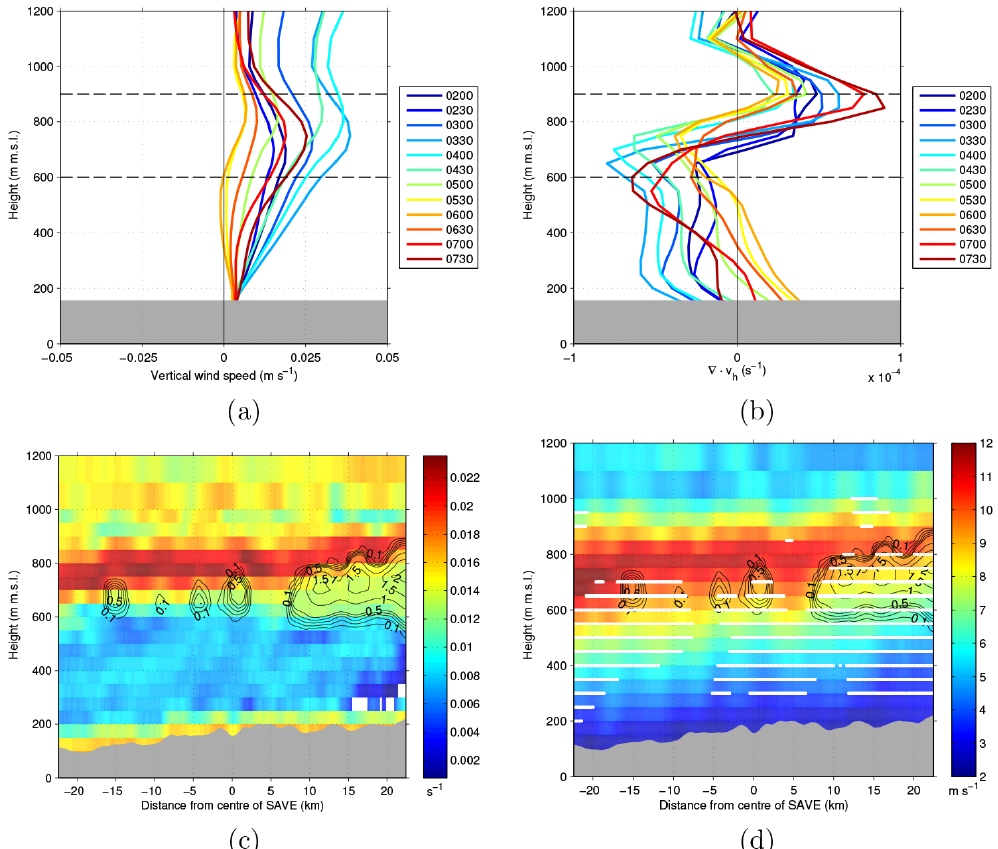
Figure 8. Profiles of vertical wind speed averaged for SAVE (a) and of horizontal wind divergence calculated for SAVE (b) at different times. Horizontal dashed lines enclose the layer where the liquid water content averaged for the shown period is larger than 0.01gkg − 1 . Vertical cross section of Brunt–Väisälä frequency (c) and horizontal wind speed (d) along a cross section through the centre of SAVE aligned along the mean wind direction of 223 ◦ at 03:45UTC. In (c) and (d) , the mean wind direction is calculated for the layer below 1000mm.s.l. and black contours indicate liquid water content in gkg − 1 . In (d) , white horizontal lines show grid points with the turbulent kinetic energy higher than 0.5m 2 s − 2 . Grey shaded areas mark the terrain